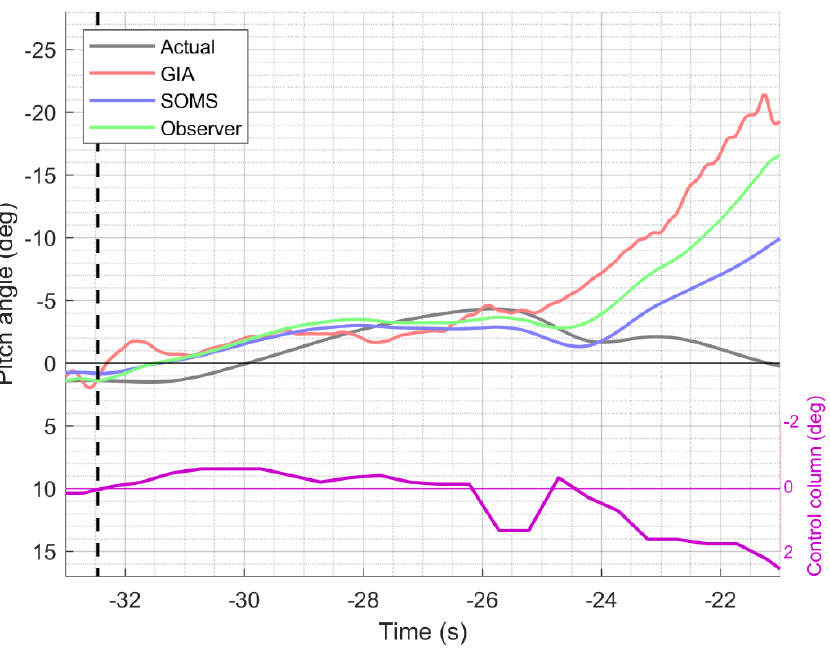
Figure 4. The same time histories as in Figure 3 but zoomed in between −3 3 and −2 1 s.